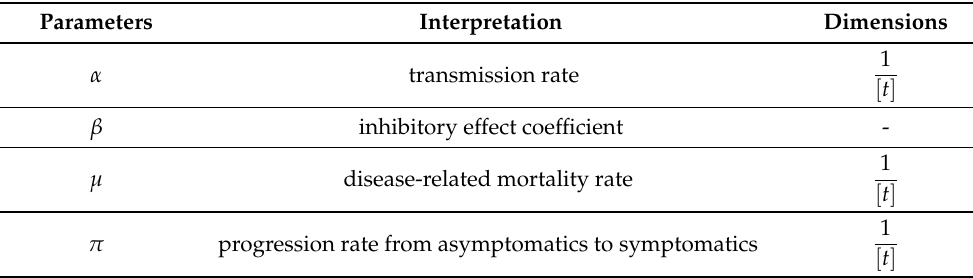
Table 2. Interpretation and dimensions of epidemiological